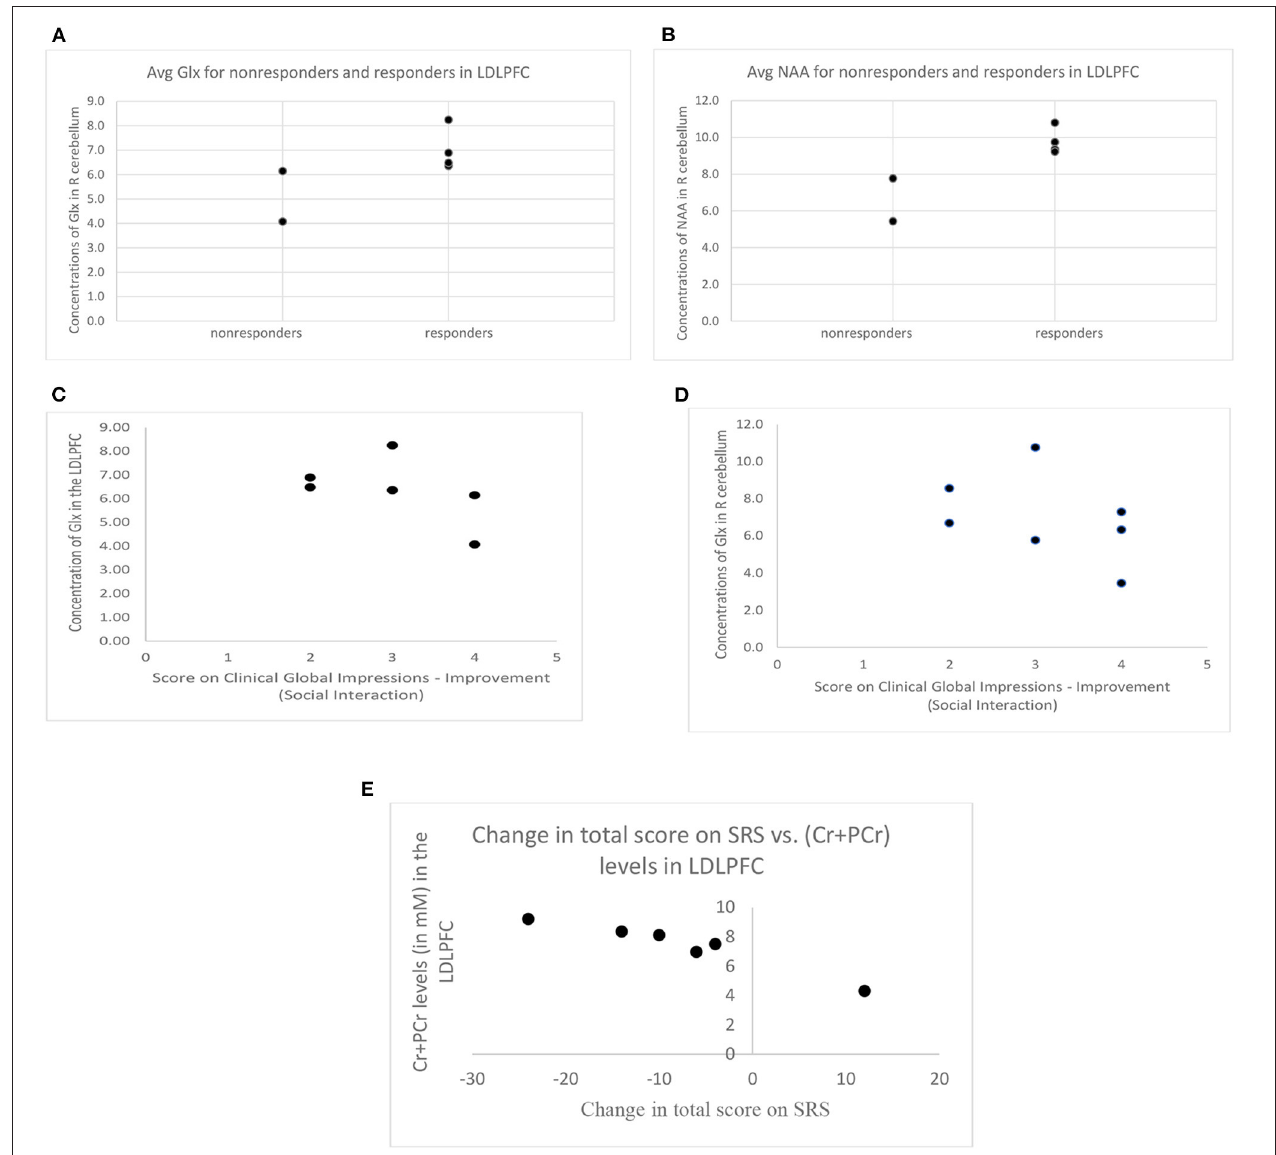
FIGURE 3 | (A) Difference in Glx concentration between responders (CGI-I score of 3 or less) and non-responders (CGI-I score of 4 or more, or withdrew due to worsening behaviors) and (B) difference in NAA concentration between responders and non-responders (error bars represent standard deviation, * = p < 0.05, # = p ≤ 0.1). (C) Concentration of Glx in the LDLPFC and (D) concentration of Glx in the R cerebellum across CGI-I scores for all participants that do have follow-up visits allowing the obtaining of CGI-I scores. (E) Change in SRS total score (negative values indicate improvement posttreatment) was negatively associated with (Cr + PCr) levels in the LDLPFC. SRS, Social Responsiveness Scale. LDLPFC, Left dorsolateral prefrontal cortex. Glx, Glutamate and its precursor glutamine; LDLPFC, Left dorsolateral prefrontal cortex; R cerebellum, right cerebellum; Cr + PCr, Creatine + Phosphocreatine; SRS, Social Responsiveness Scale; CGI-I, Clinical Global